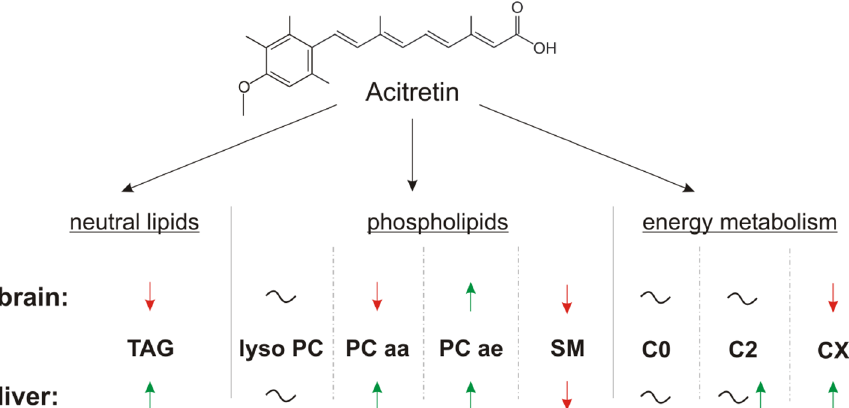
Figure 8. Summary of the observed effects of acitretin on the analyzed neutral lipids, phospholipids and on energy metabolism in brain and liver tissue of and 5xFAD mice. FAD: Familial Alzheimer´s Disease. FA: fatty acid. TAG: triacylglycerides. lyso-PC: lyso-phosphatidylcholine. PCaa: phosphatidylcholine. PCae: phosphatidylcholine-plasmalogen. SM: